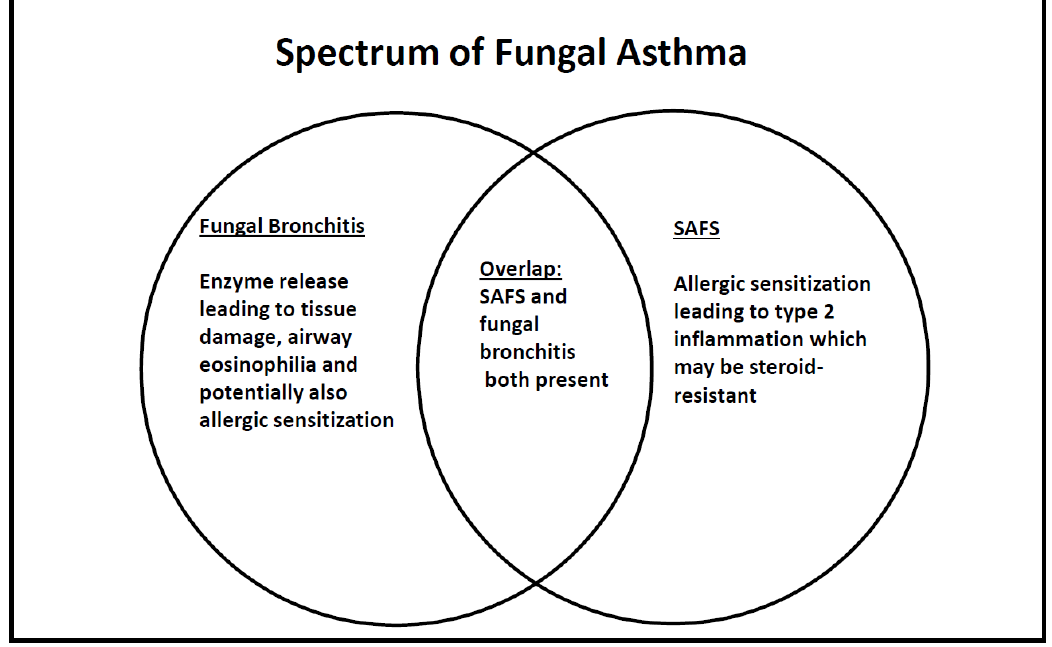
Figure 1. Schematic of fungal involvement in asthma in children, in whom the diagnosis of allergic bronchopulmonary aspergillosis (ABPA) is rarely